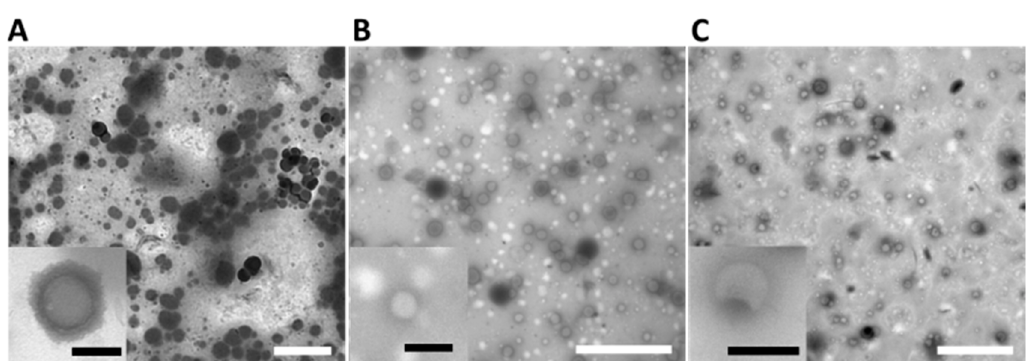
Figure 7. Transmission electron microscopy (TEM) pictures of block copolymer brush particles (sample 1) in selective solvent systems. ( A ) THF/water (90/10 w / w ). ( B ) THF/CH 3 OH (82/18 w / w ). ( C ) DMSO/CHCl 3 (82/18 w / w ). Scale bars are all of 1 µm for the main pictures and of 125 nm for the enlargements.